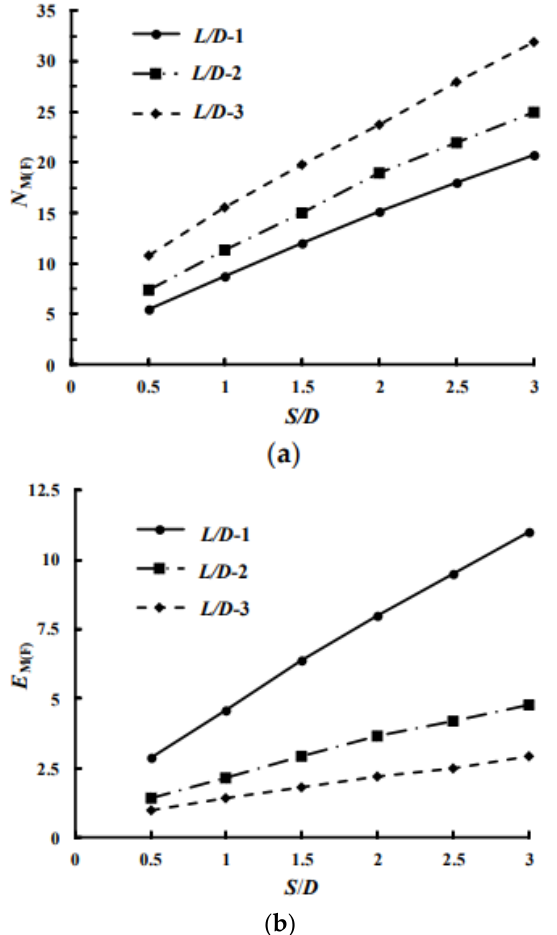
Figure 10. Moment dimensionless load and group efficiency with L / D and S / D ratios: ( a ) moment dimensionless load N M(F) ; ( b ) group efficiency E M(F) .